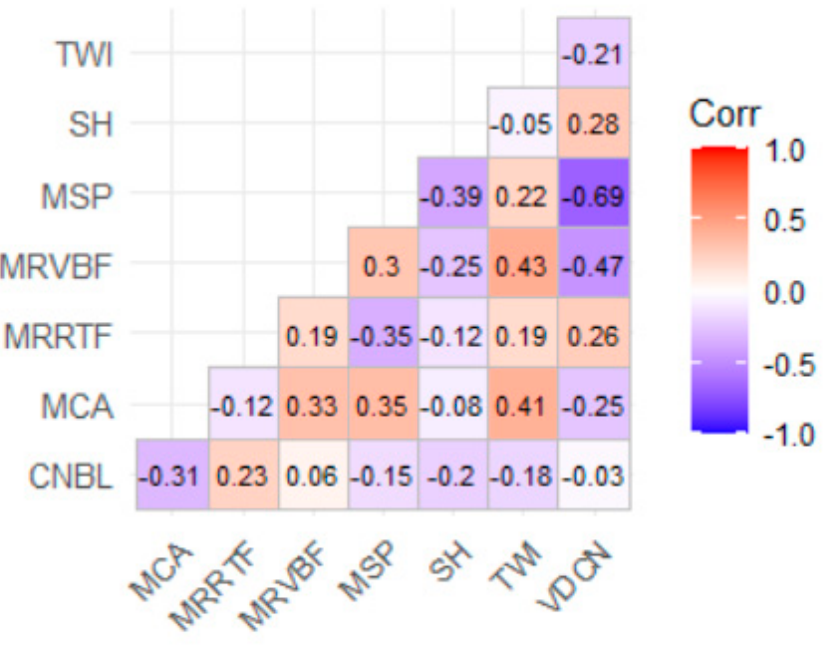
Figure 4. Correlation among the predictors. Table 3. Spearman’s rank correlation rho between soil properties and terrain attributes.